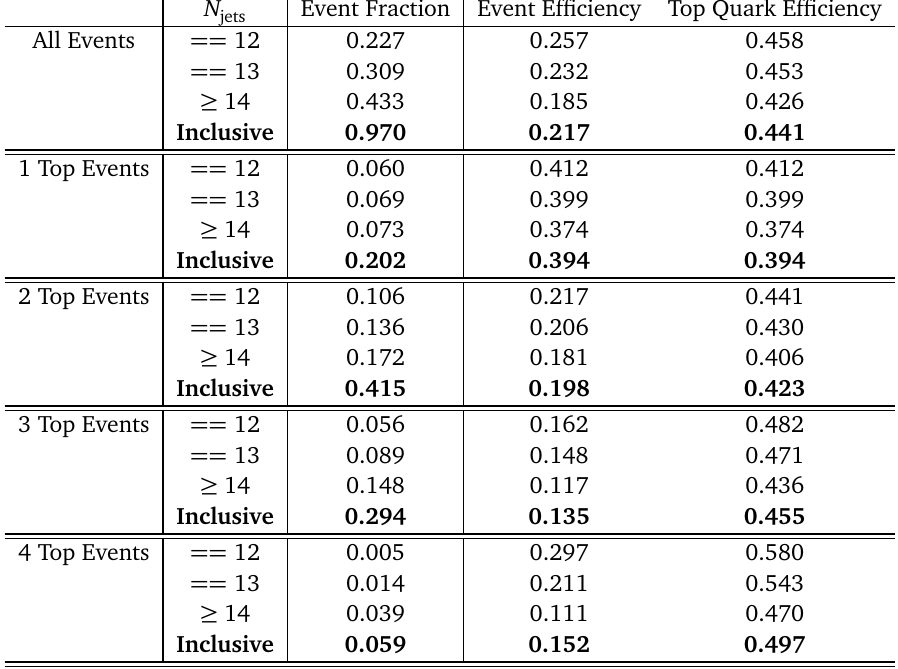
Table 12: S PA -N ET results on t ¯ tt ¯ t with at least 2 b -tagged jets (all generated events).